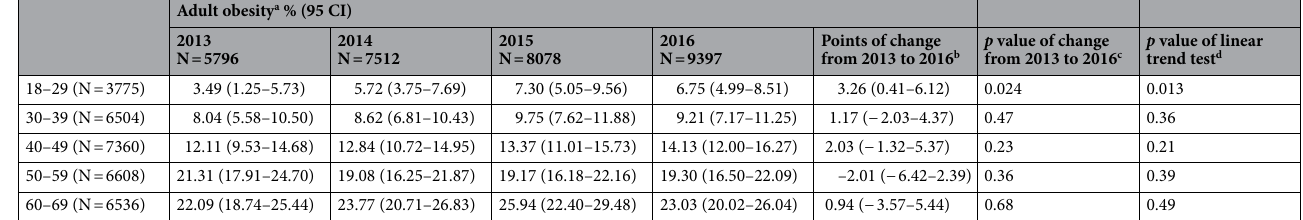
Table 3. Linear trend of obesity by age, weighted and age and sex-adjusted prevalence, 2013–2016 in men (N = 30,783). a Adult obesity defined as BMI ≥ 30 kg/m 2 . b Percentage point. c From the t-test of the change from 2013 to 2016. d From the coefficients of orthogonal polynomials corresponding to linear contrast. Age